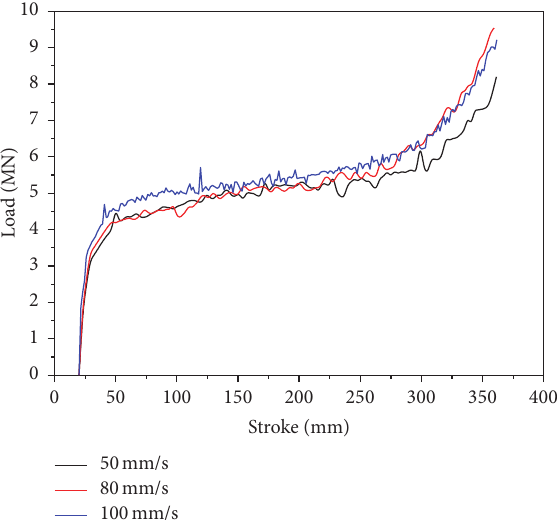
Figure 12: Effect of deformation speed on the load-stroke curves.